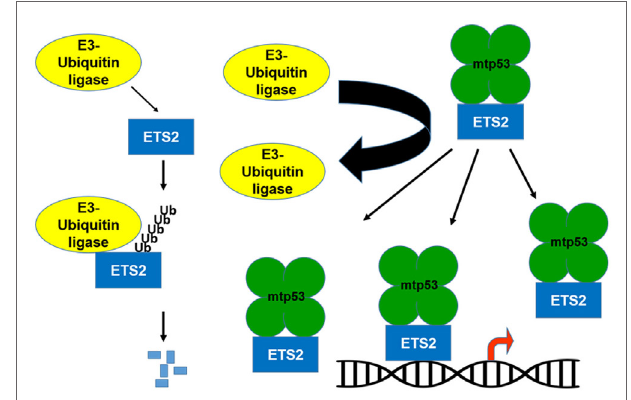
FiGURe 1 | Mutant p53 protects eTS2 from degradation . ETS2 is a labile protein with a short half-life. An E3-ubiquitin ligase binds to ETS2 and promotes its ubiquitin-dependent degradation. In the presence of mtp53, ETS2 is not ubiquitinated and becomes stable, which increases its abundance allowing it to recruit mtp53 to ETS target